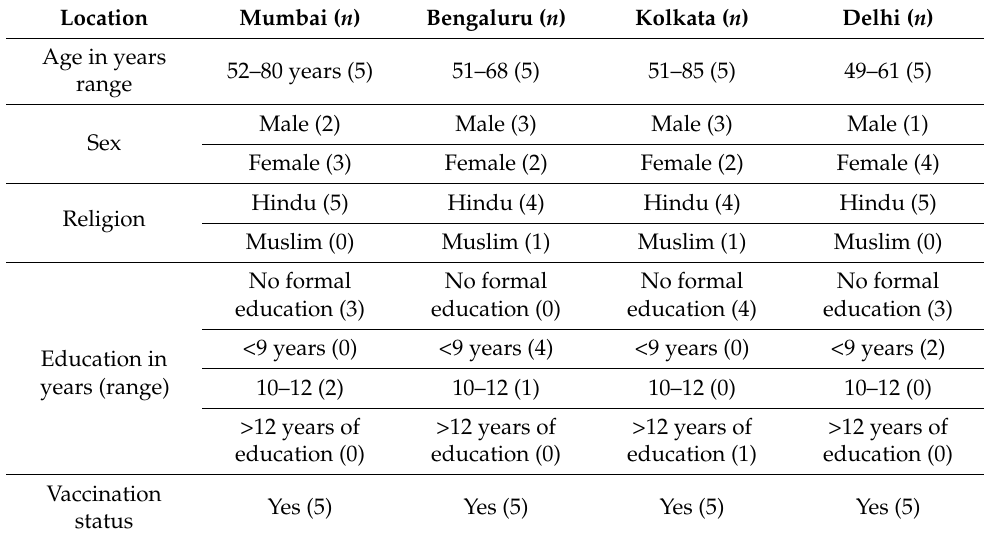
Table 3. Socio demographic profile of in-depth interview of community members from Mumbai, Bengaluru, Kolkata and Delhi.